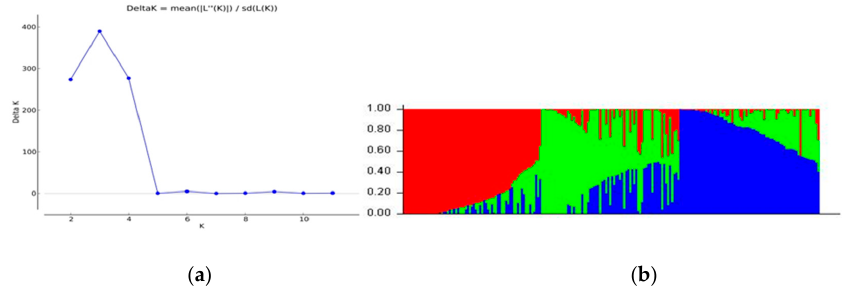
Figure 1. Graphical representation of the population structure of the 208 maize panel. ( a ) Plot of mean likelihood of delta K against the number of K groups. The highest peak observed at K = 3 signifies the grouping of accessions into three groups, while the small peak at K = 2 and 4 signifies further grouping of accessions into two and four groups, respectively. ( b ) Subpopulations at K = 3. The colors represent three subpopulations of 208 accessions. The separation of accessions into subpopulation 1 (red), 2 (green), and 3 (blue) was based on membership coefficient ≥ 80%.